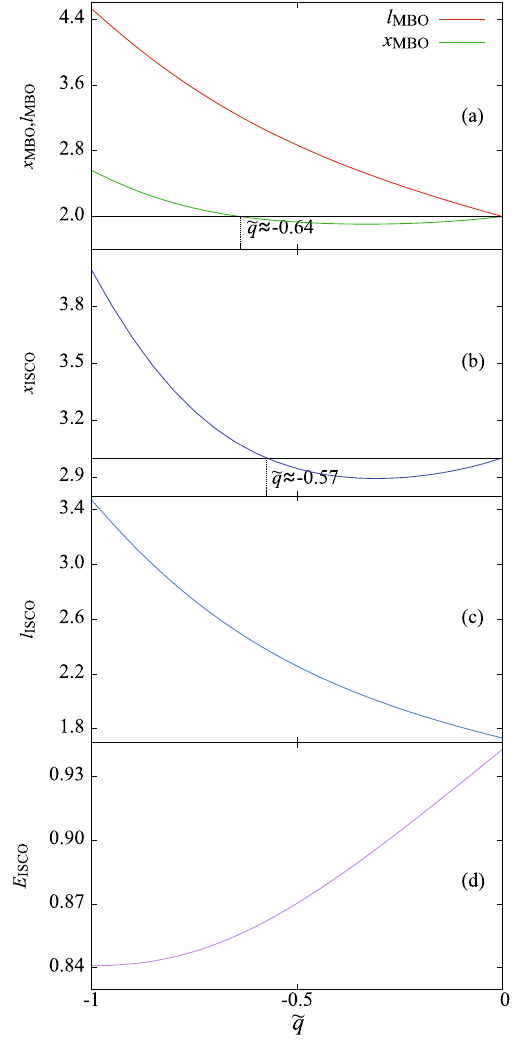
Fig. 3 x MBO , l MBO , x ISCO , l ISCO and E ISCO of a neutral timelike par- ticle around the hairy black hole with respect to the dimensionless cou- pling values ˜ q